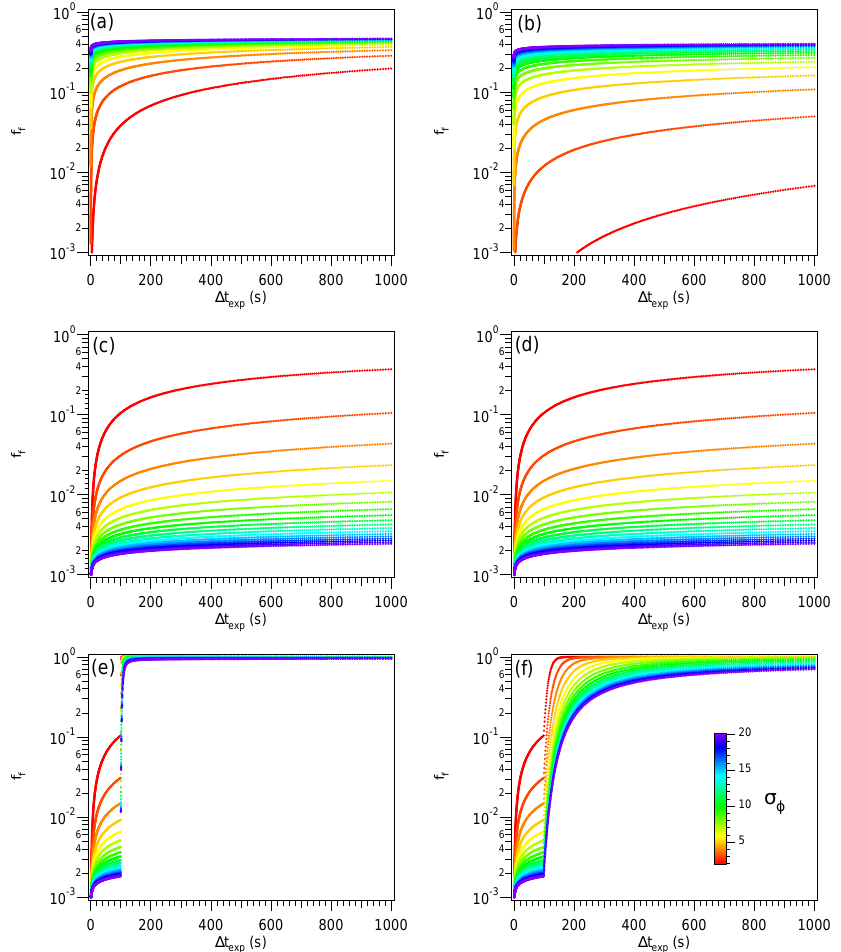
Fig. 4. Ice nucleation fraction vs. observation time at T = 220K, for IN with ¯ θ = 6 ◦ (left panels) and ¯ θ = 23 ◦ (right panels). (a) Constant S i = 1 . 023. (b) Constant S i = 1 . 345. (c–d) S i is increased over 1s up to the point where f f = 0 . 001 and then maintained constant afterwards. (e–f) As (c) and (d) but S i is increased by 0 . 001 after 1t exp = 100s. The particle mean surface area was set to ¯ s p = 10 µm 2